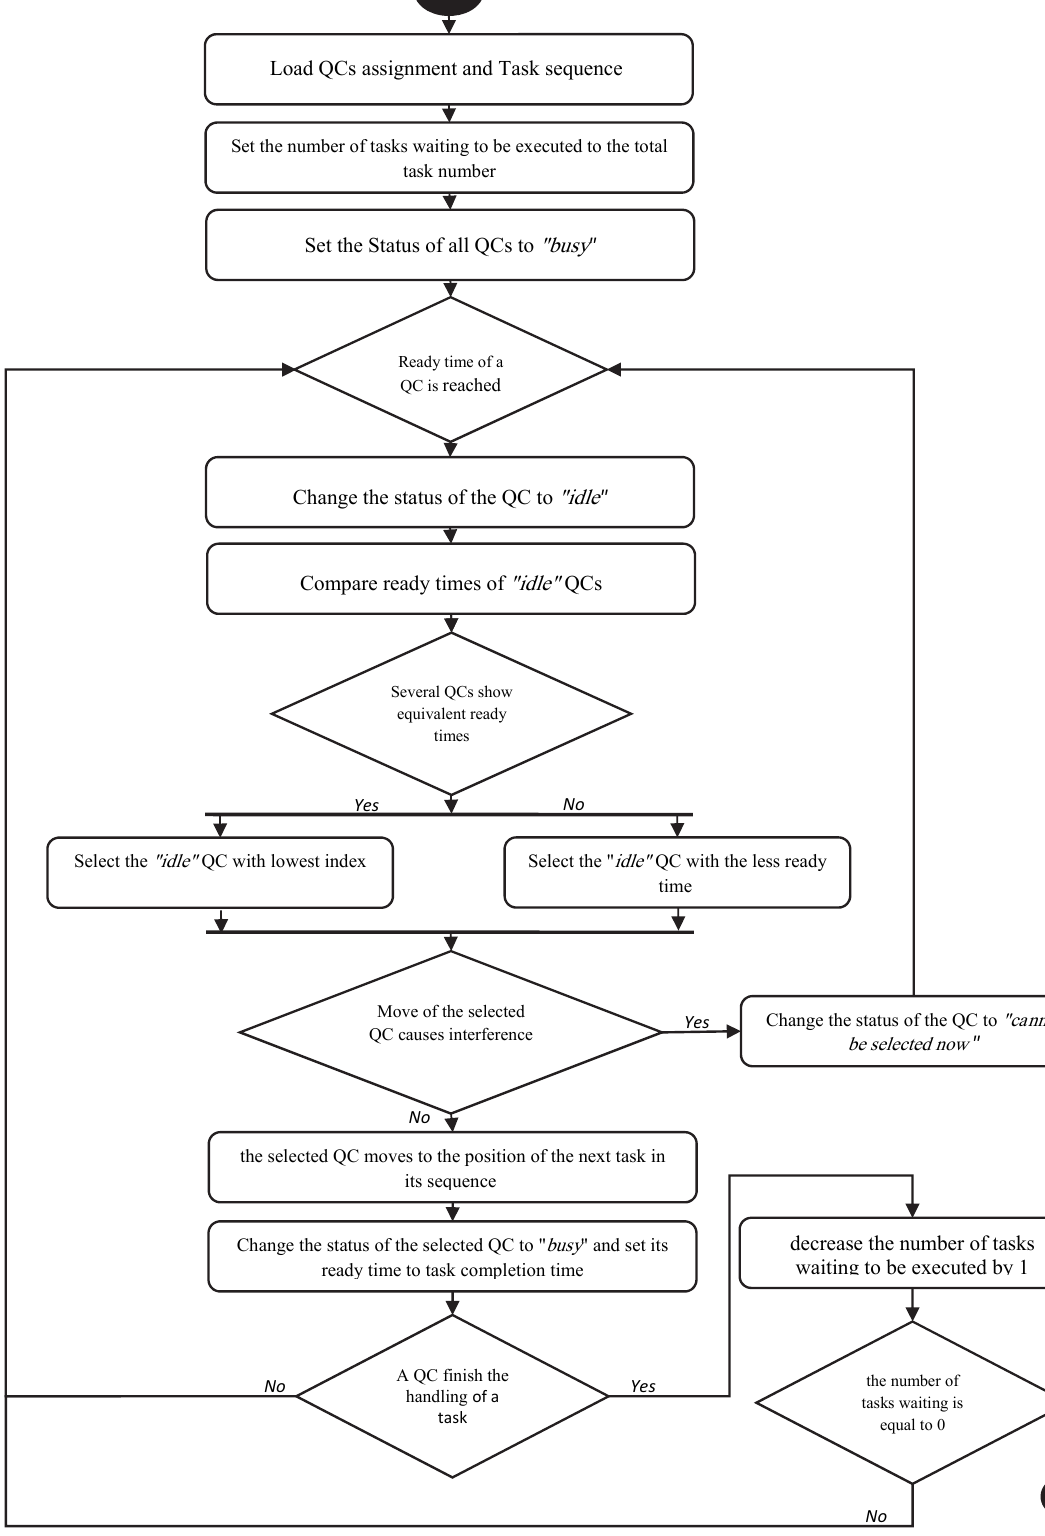
Fig. 4. Flowchart of the Discrete Event